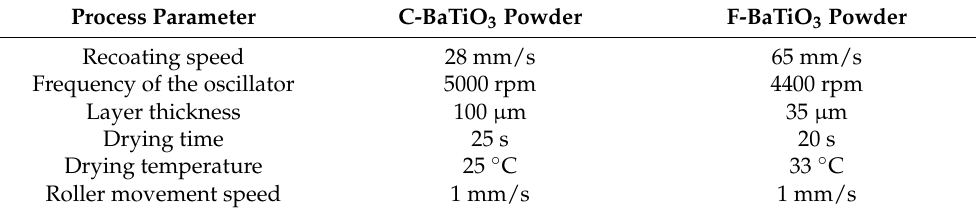
Table 1. The main BJ parameters for BaTiO 3 lead-free piezoceramic powder. Process Parameter C-BaTiO 3 Powder F-BaTiO 3 Powder Recoating speed 28 mm/s 65 mm/s Frequency of the oscillator 5000 rpm 4400